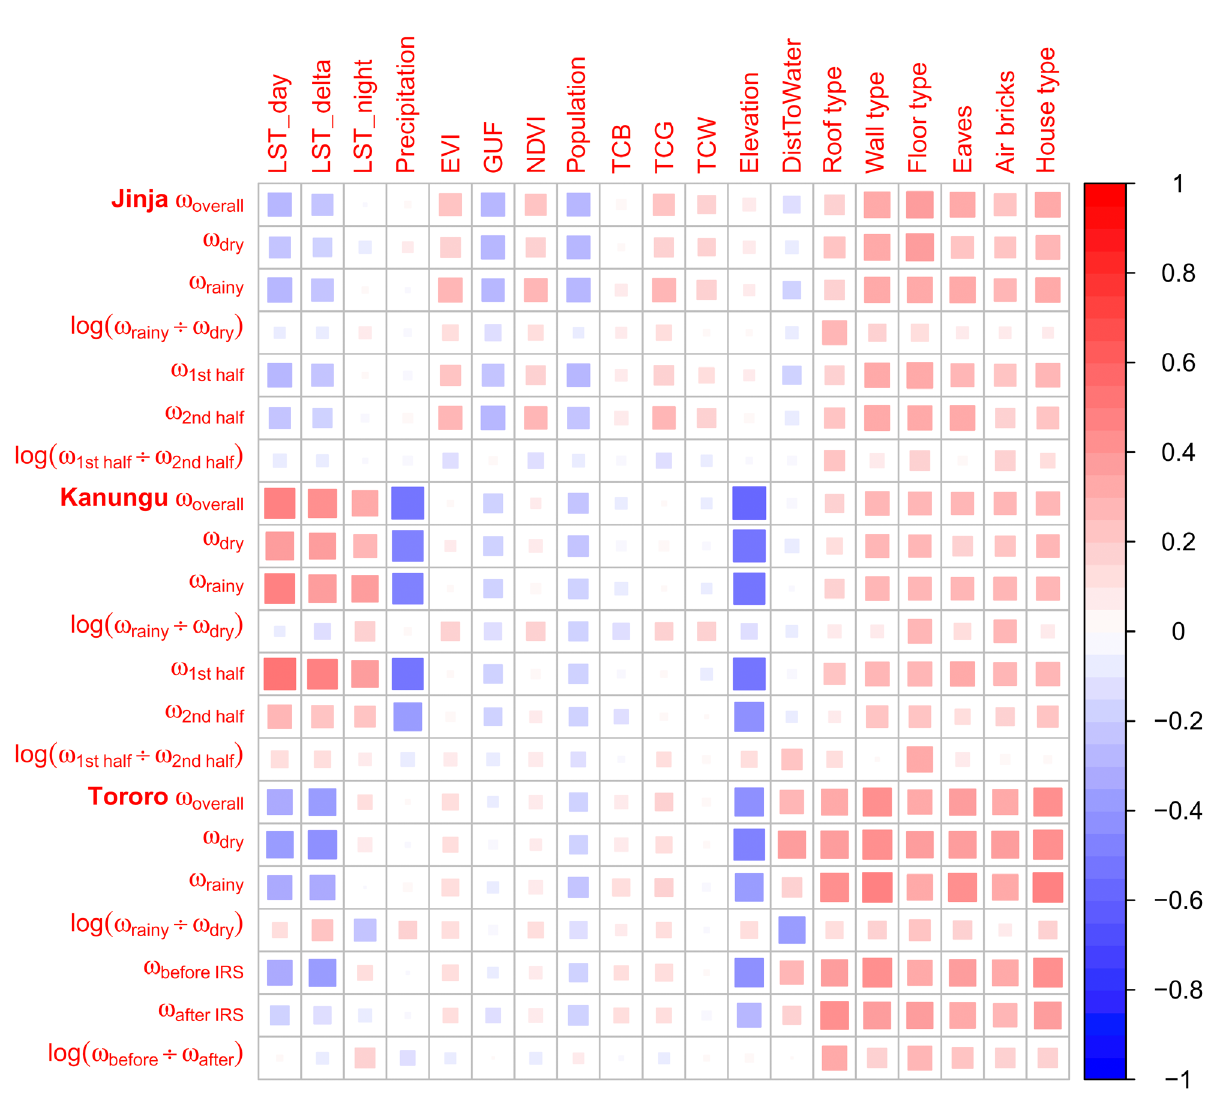
Figure 6. Correlation heatmap of household biting propensities and environmental and housing covariates. See Table 1 for descriptions of the covariates. The size of the squares and the shade of colors both illustrate the magnitude of the correlation. Red-shaded squares denote positive correlation whereas blue-shaded squares denote negative